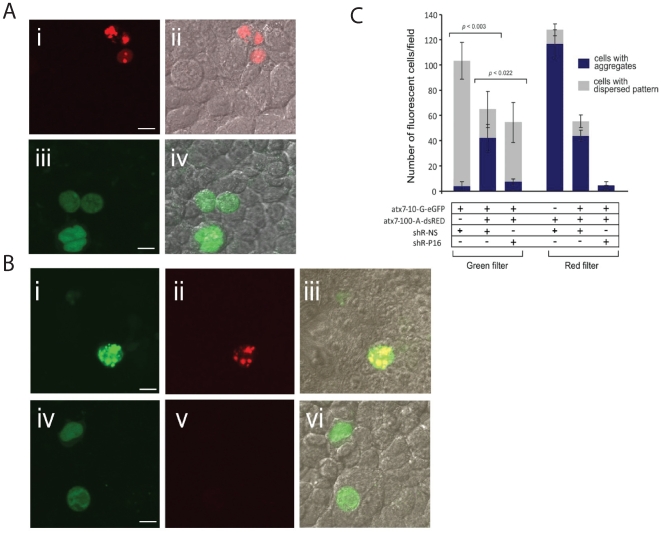
Investigation of aggregate formation.(A) Representative confocal images of cells transfected with (i, ii) mutant (atx7-100-A-DsRED) alone; (iii, iv) wild-type (atx7-10-G-eGFP) alone. (i) Image visualized under red fluorescence, (ii) red fluorescence merged with the bright field, (iii) green fluorescence, and (iv) green fluorescence merged with the bright field. (B) Representative confocal images of cells co-transfected with wild-type and mutant expression plasmids in addition to (i–iii) shR-NS or (iv–vi) shR-P16. (i) and (iv) show images under green fluorescence to reveal wild-type protein, (ii) and (v) show images under red fluorescence to reveal mutant protein, and (iii) and (vi) show images then merged under green and red fluorescence and bright field. Scale bar represents 10 µm. C. Cells expressing eGFP and/or DsRED were counted according to whether they contained aggregates or a dispersed pattern of expression of mutant and wild-type ataxin-7. Cells were transfected with wild-type target (atx-10-G-eGFP) alone; mutant target (atx7-100-A-DsRED) alone; mutant (atx7-100-A-DsRED), wild-type (atx-10-G-eGFP) and shR-NS (non-specific shRNA); mutant, wild-type and shR-P16. Cells were counted separately in the red and the green filter by collecting 3 representative images from each well and combining the total number. This was performed for each indicated combination in biological triplicate, yielding standard deviations. The bars comprise the total number of cells counted in each transfection; separated according to whether they contained aggregates (blue) or a dispersed pattern of expression (grey). Note that the decrease in expression from target vectors transfected alone to co-transfected cells is due to a promoter occlusion effect of co-expression of targets and not due to the addition of shR-NS which has no effect upon the target vectors (data not shown). Statistically significant differences in % of aggregate containing cells are indicated by corresponding p values.